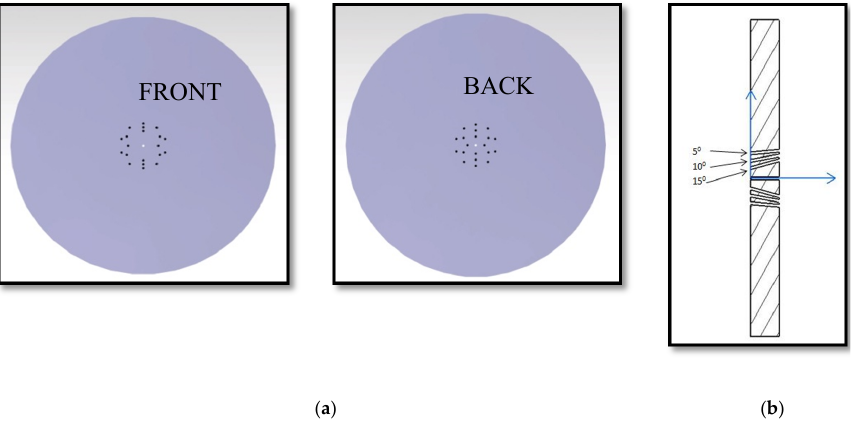
Figure 3. Catia V5 model of ( a ) shower head injector, ( b ) Exploded sectional view of shower head injector.